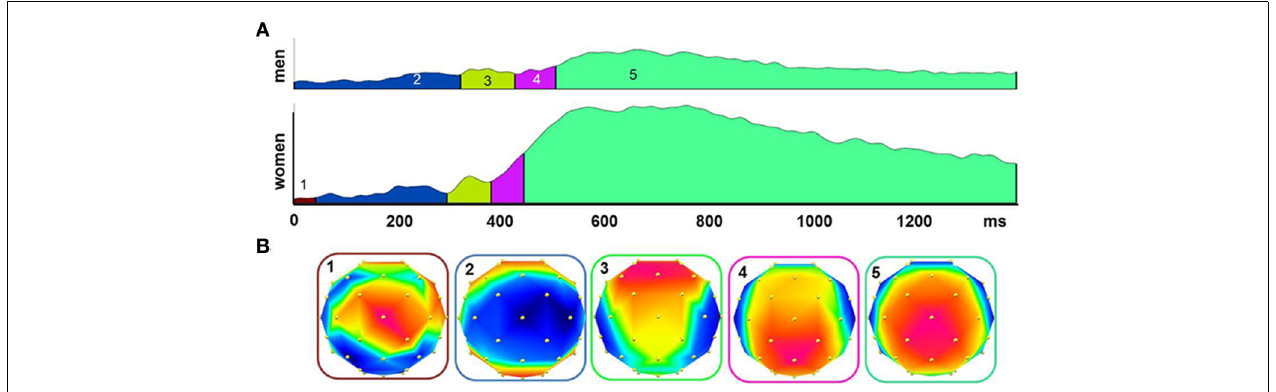
FIGURE 2 | The global field power (GFP) to all stimulants for men and women were segmented into quasi-stable microstates using a topographic cluster analysis (A). Different microstates are indicated by